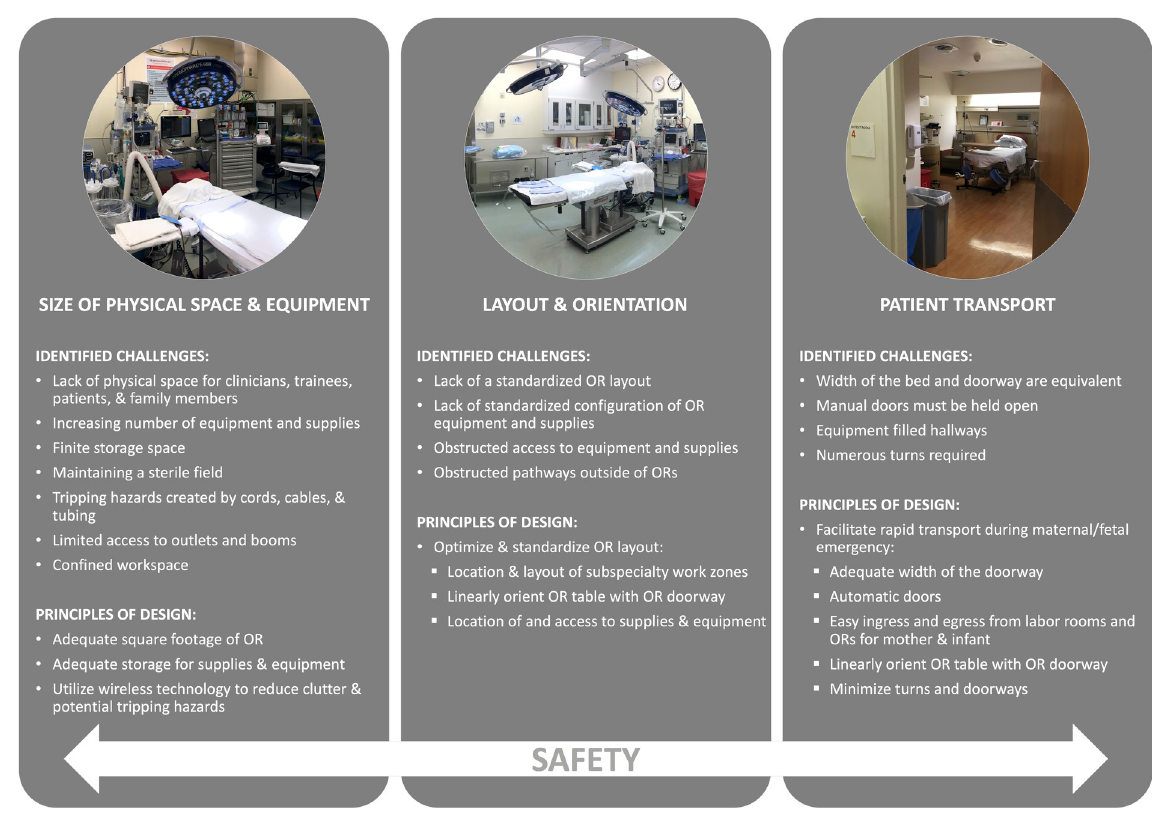
Fig 5. Key points: Identified challenges during an emergency Cesarean and relative principles of design.